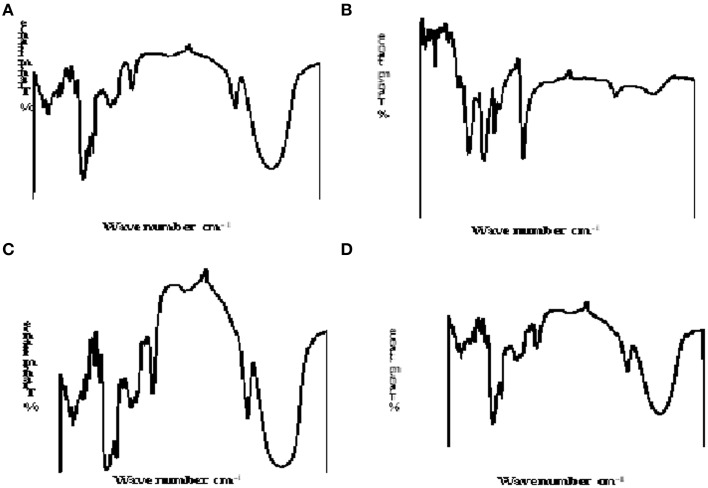
IR spectra of (A) native white yam. (B) carboxymethylated white yam starch; (C) native bitter yam and (D) acid-modified bitter yam.